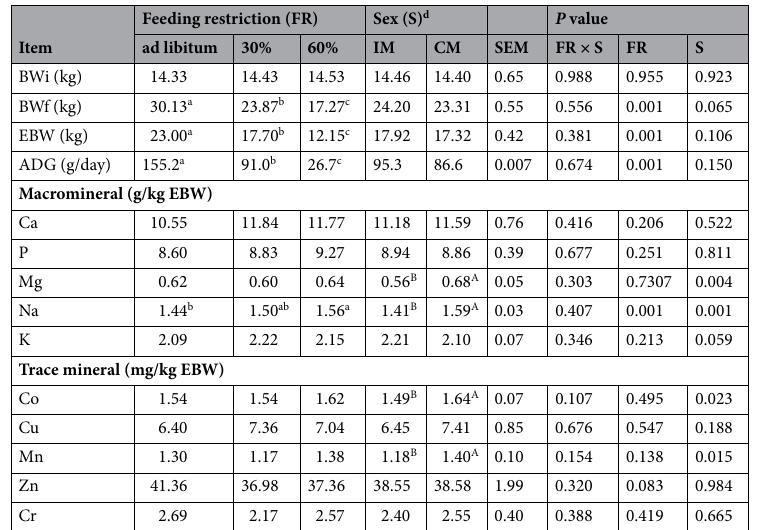
Table 3. Body parameters and mineral composition in the EBW of intact and castrated male Santa Ines hair sheep. d IM intact male, CM castrated male, BWi initial body weight, BWf final body weight, EBW empty body weight, ADG average daily gain. Different letters ( abc ) indicate that the feeding restriction differed ( P < 0.05; Tukey–Kramer test). Different letters ( AB ) indicate that the sex differed ( P < 0.05; Tukey–Kramer